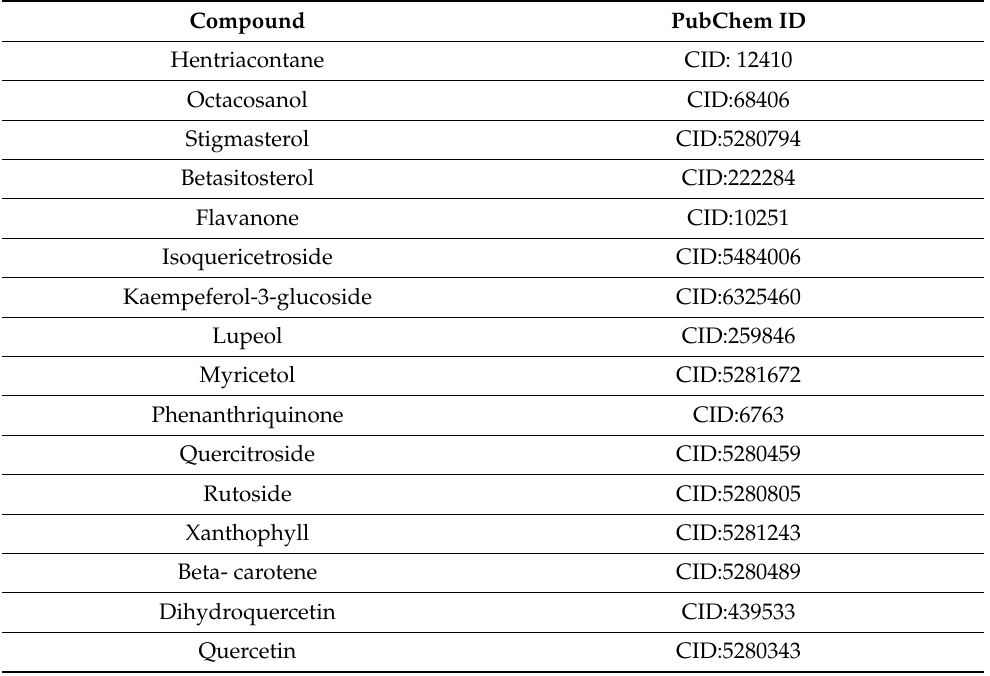
Table 4. Compounds and their respective PubChem